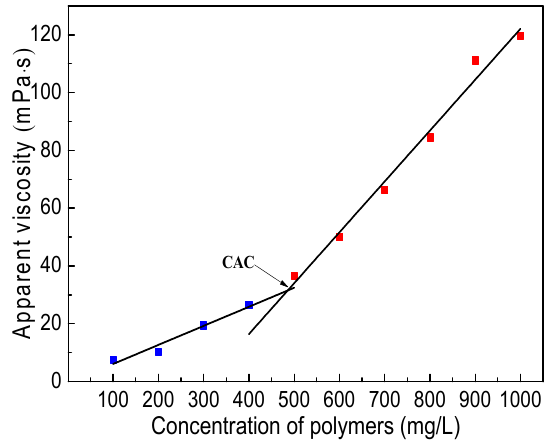
Figure 3. The critical association concentration (CAC) of DiPHAM.